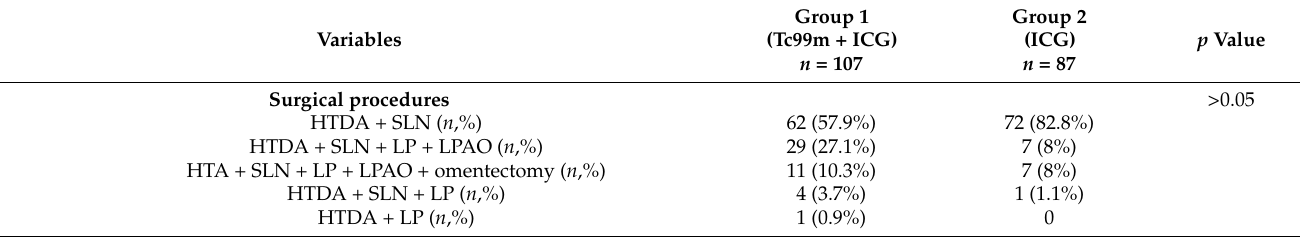
Table 2. Surgical procedures of both groups and final pathology results ( n = total number of patients; SD = standard deviation; ICG = indocyanine green; Tc99m = technetium99; HTDA = hysterectomy and double adnexectomy; SLN = sentinel lymph node; LP = pelvic lymphadenectomy; LPAO = paraaortic lymphadenectomy; * Significant